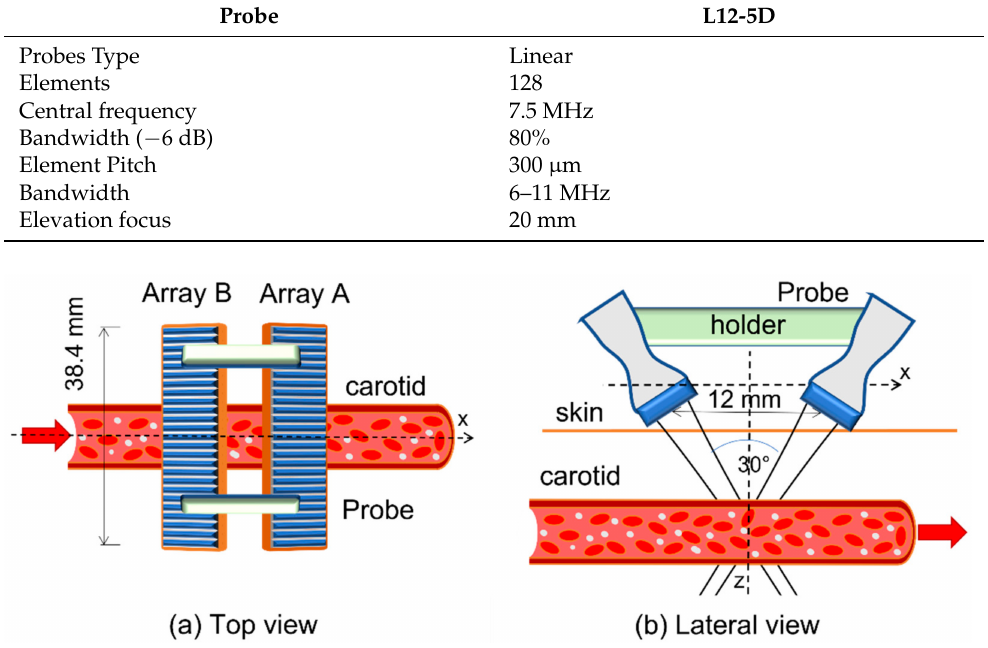
Figure 1. The proposed probe is composed of 2 linear arrays of 38.4 mm lateral extension, spaced by 11 mm. The arrays are tilted so that a 30 ◦ angle is present between their